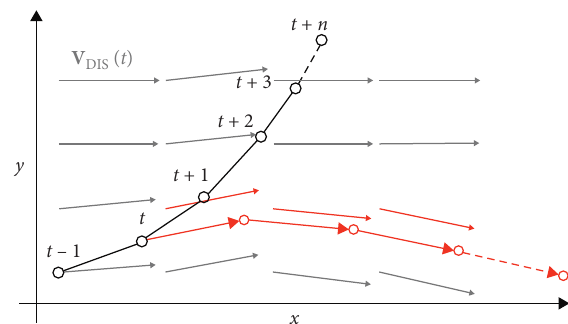
Figure 4: In the DIS-Lin1 model, the vector v arrow) obtained from V linearly extended to t + n .